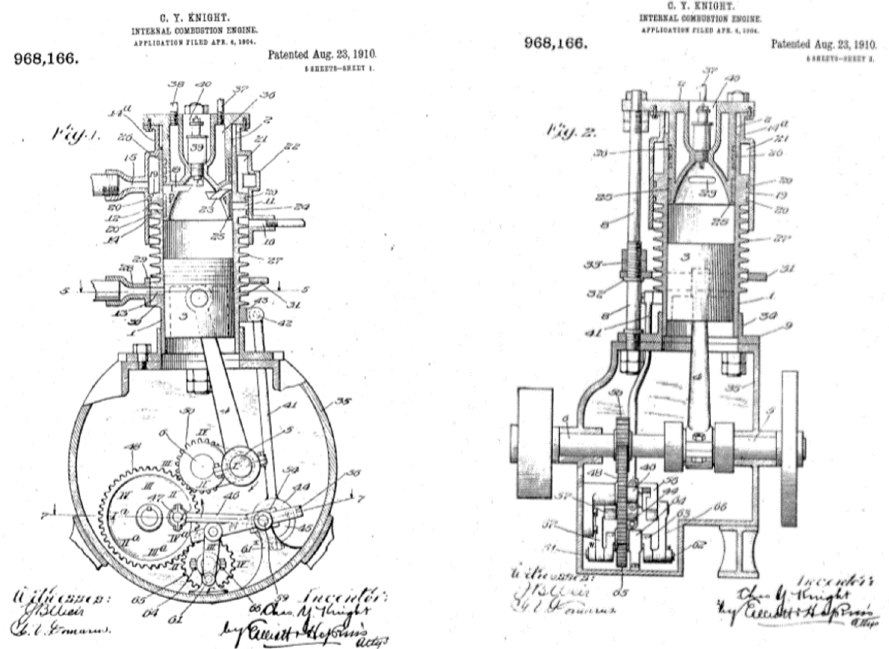
Figure 1. C.Y. Knight patent for internal combustion engine US patent 968166 filed 4 April, 1904.